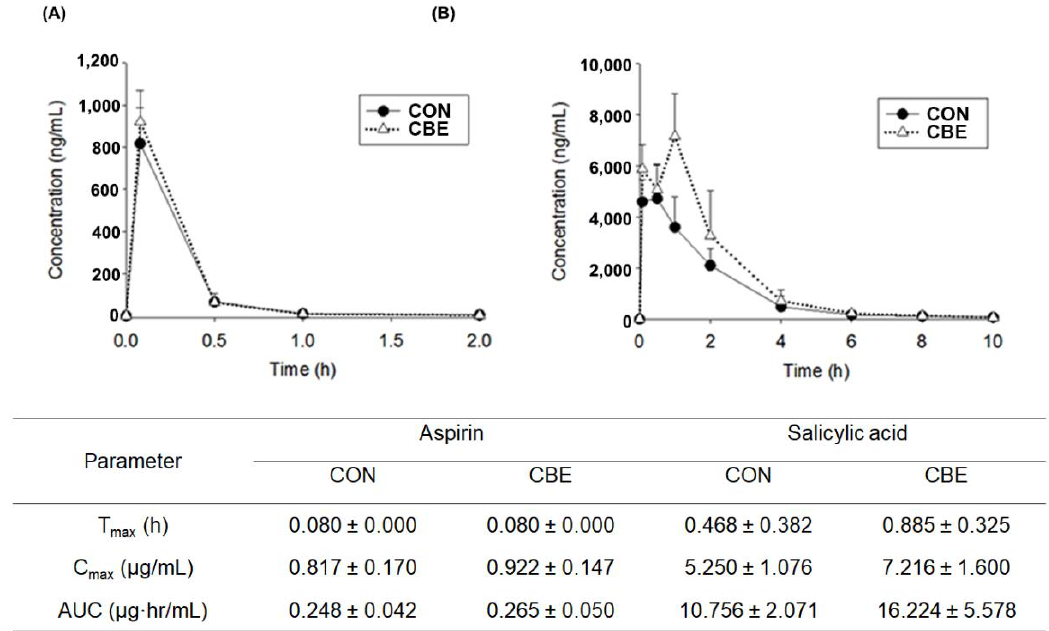
Figure 3. The enzyme activities of human and mouse fecal samples. ( A ) The fecal aspirin-metabolizing activities. ( a ) The fecal aspirin-metabolizing activities of humans. ( b ) The fecal aspirin-metabolizing activities fo mice treated with coffee bean extract (CBE) or vehicle (NOR) ( b ). ( B ) The β -glucuronidase, β -galactosidase, β -glucosidase, lipase, and sulfatase activities were analyzed in the feces of mice with CBE or vehicle. Data are shown as the mean ± S.D. ( n = 6). Means with same letters are not significantly different ( p < 0.05).